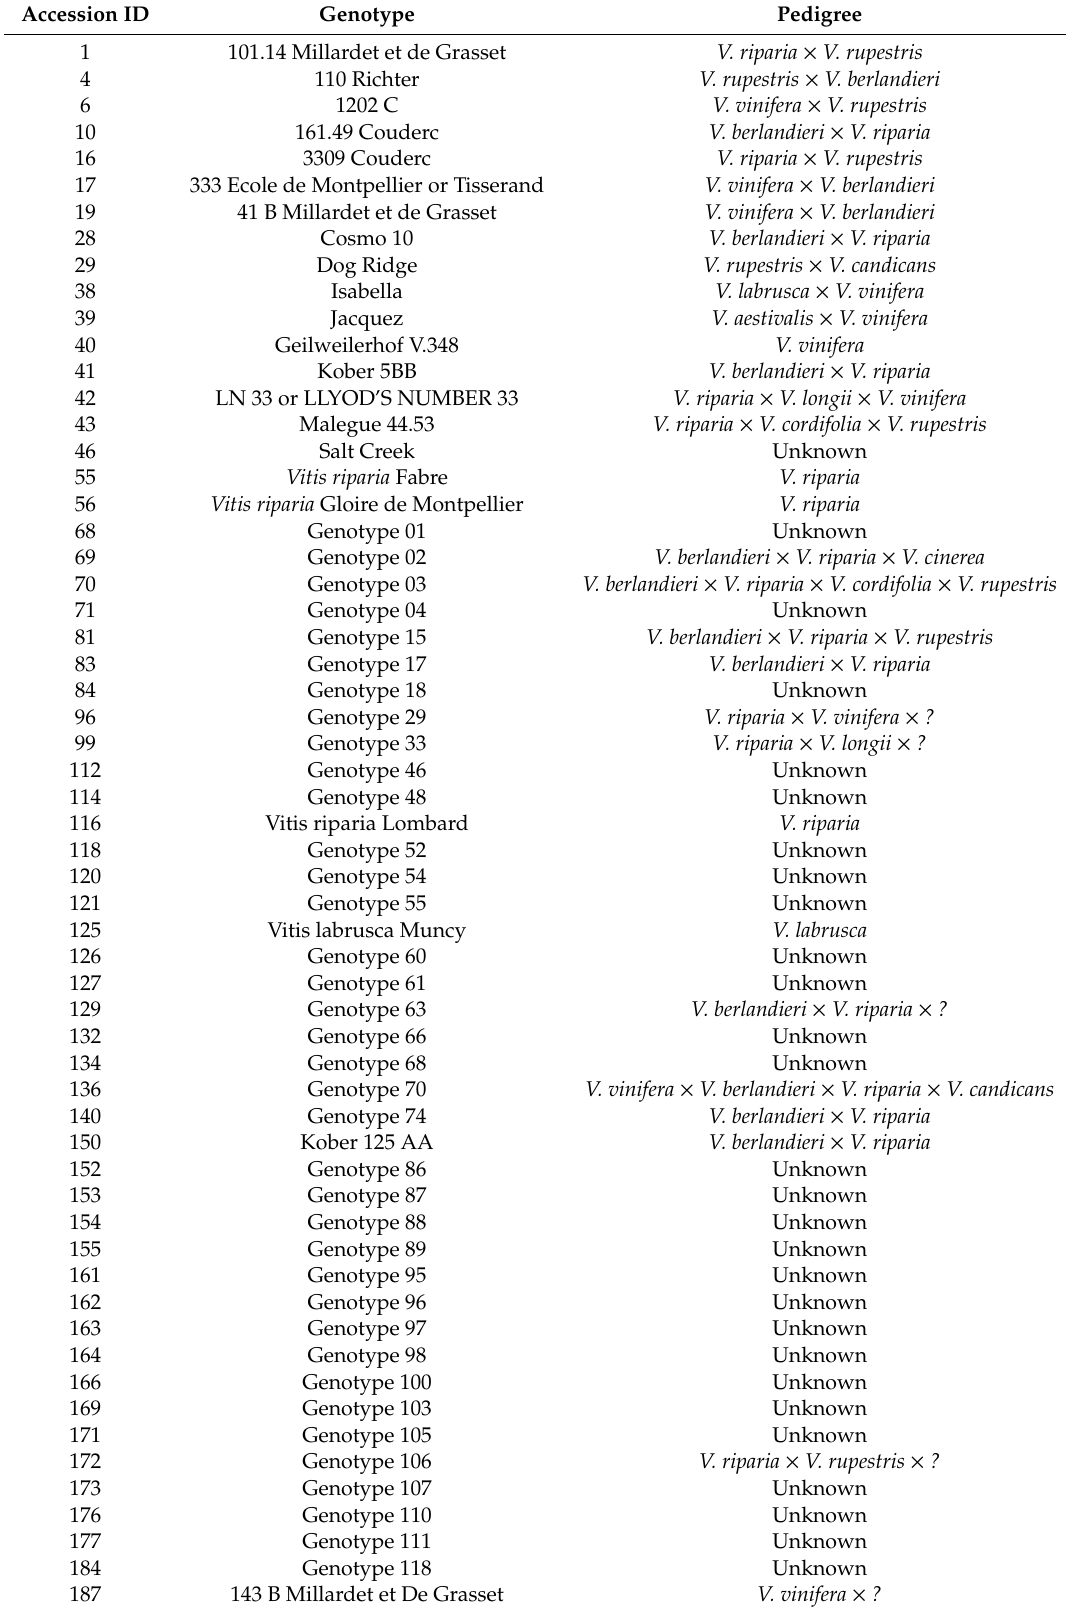
Table 1. List of the vine rootstock core collection. The genotype name and the breeding material is reported for each accession